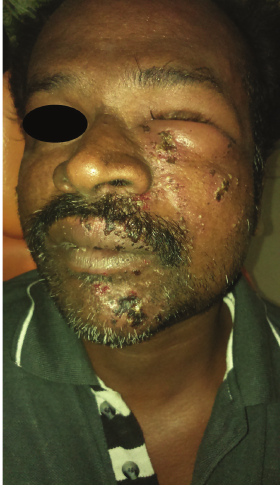
Figure 1: Vesicles showing unilateral distribution extraorally.